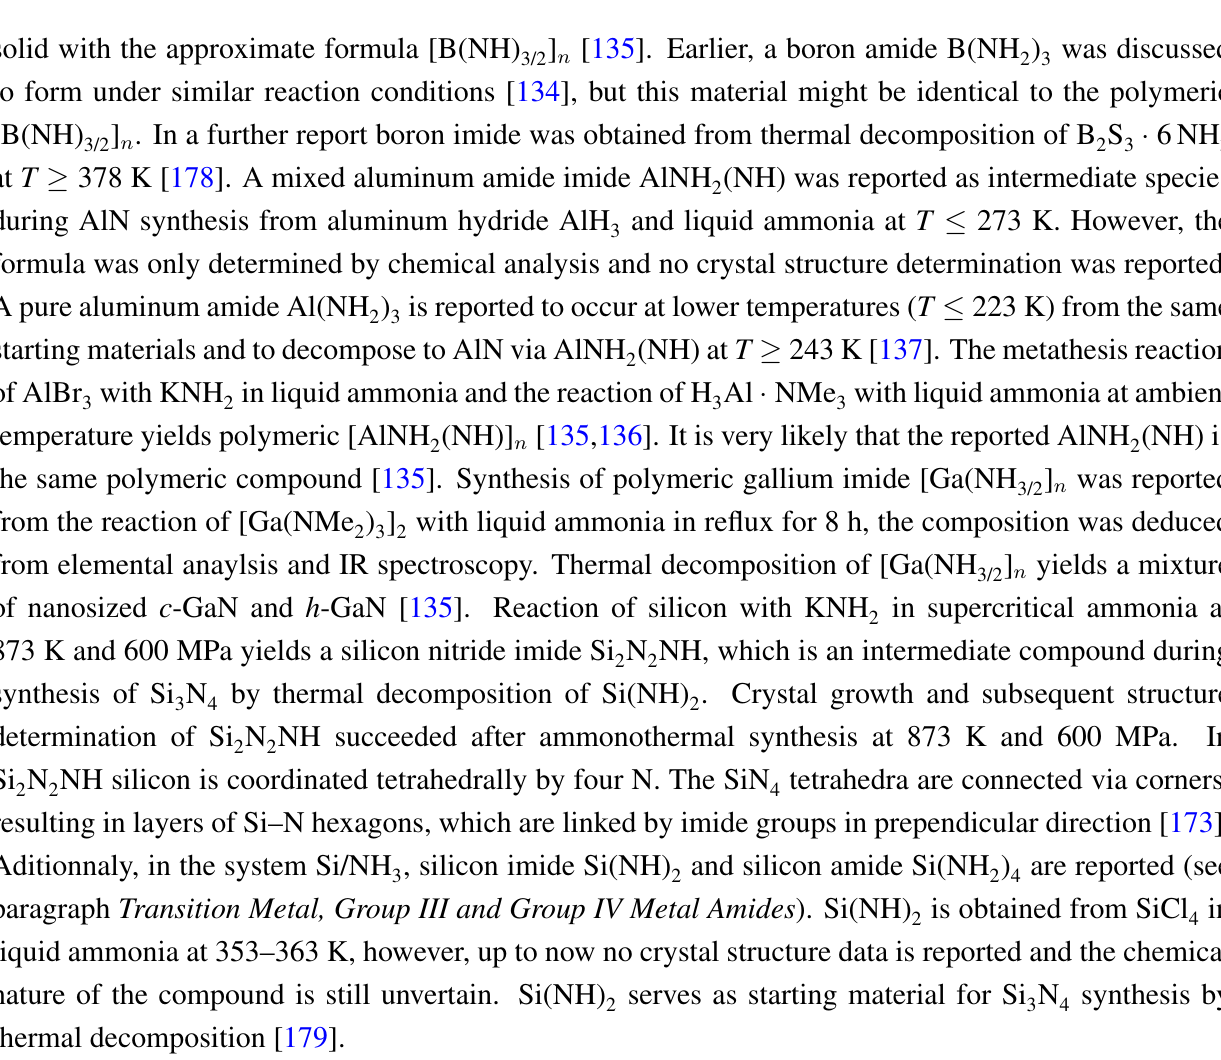
Table 9. Conditions for the ammonothermal synthesis of metal hydrides and hydride nitrides.